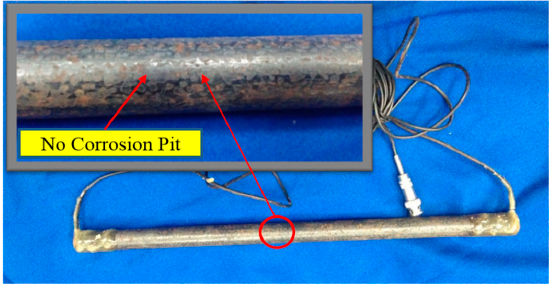
Figure 9. Steel bar without corrosion.